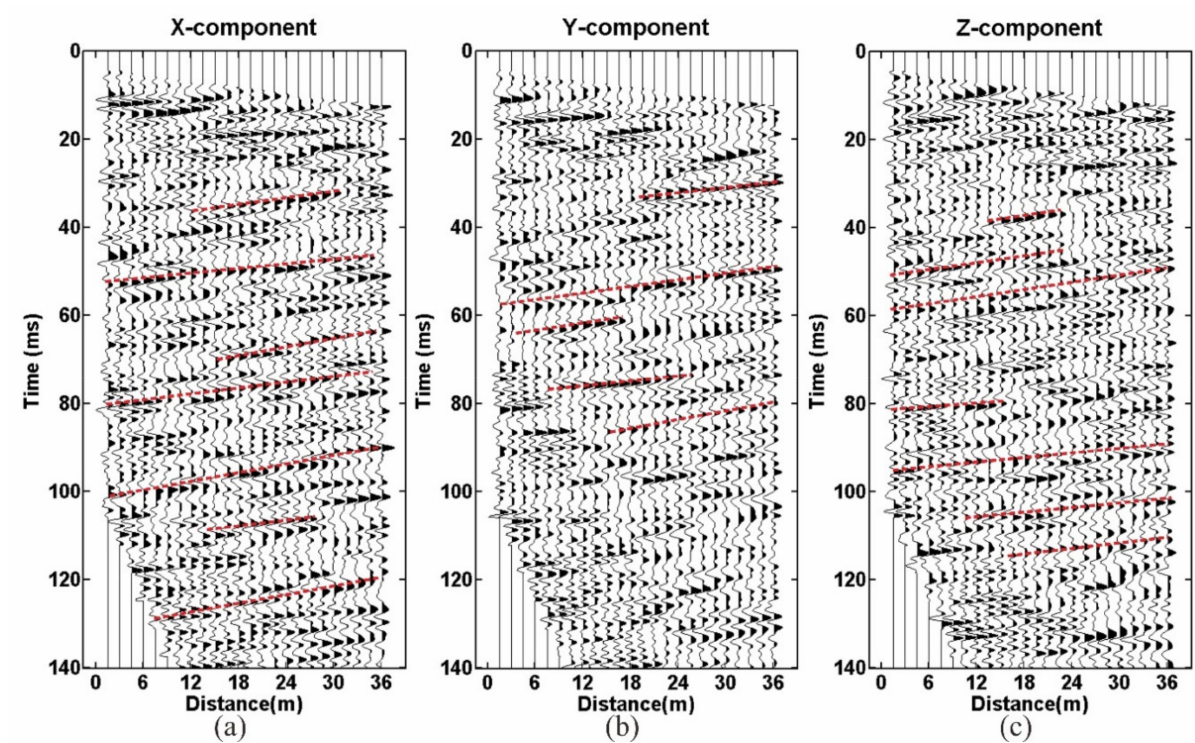
Figure 12. The processed data of geophone R-1: ( a ) X-component; ( b ) Y-component; ( c ) Z-component.